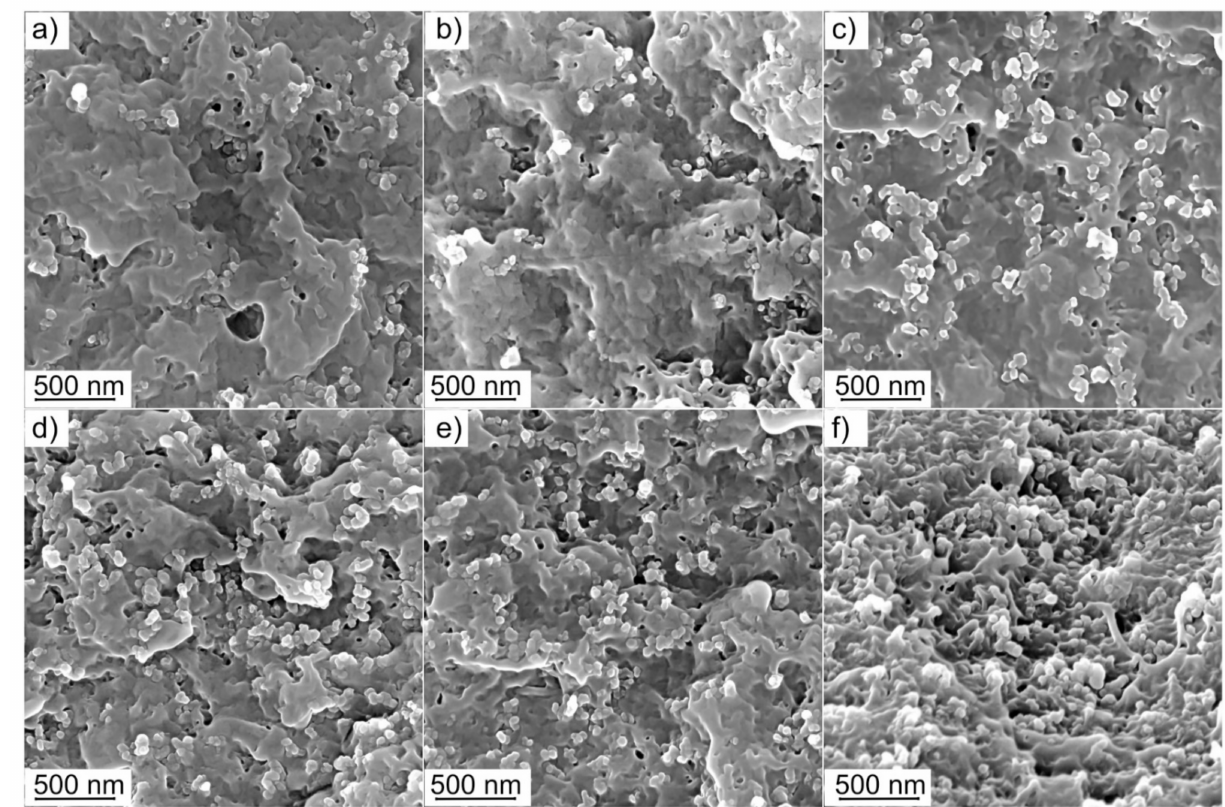
Figure 2. SEM images of CB-reinforced PA66 melt compounded composites with different filler content: 14 % ( a ), 16 ( b ), 17 ( c ); 18 ( d ); 21 ( e ) and 27 wt. % ( f ),